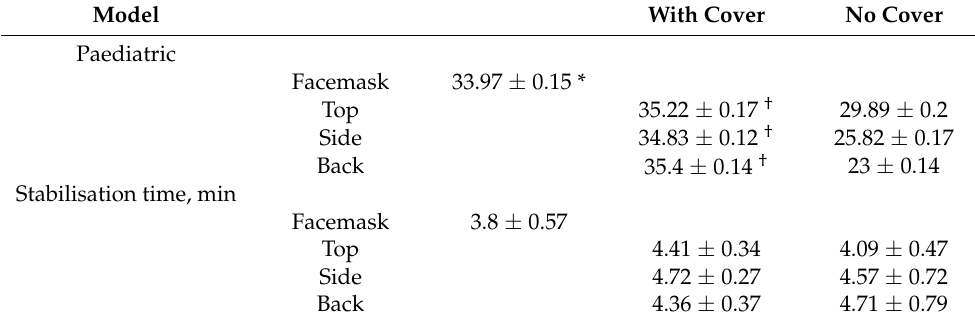
Table 2. Cont. Model With Cover No Cover Paediatric Facemask 33.97 ± 0.15 * Top Back 23 ± 0.14 Stabilisation time, min Facemask 3.8 ± 0.57 Top 4.41 ±